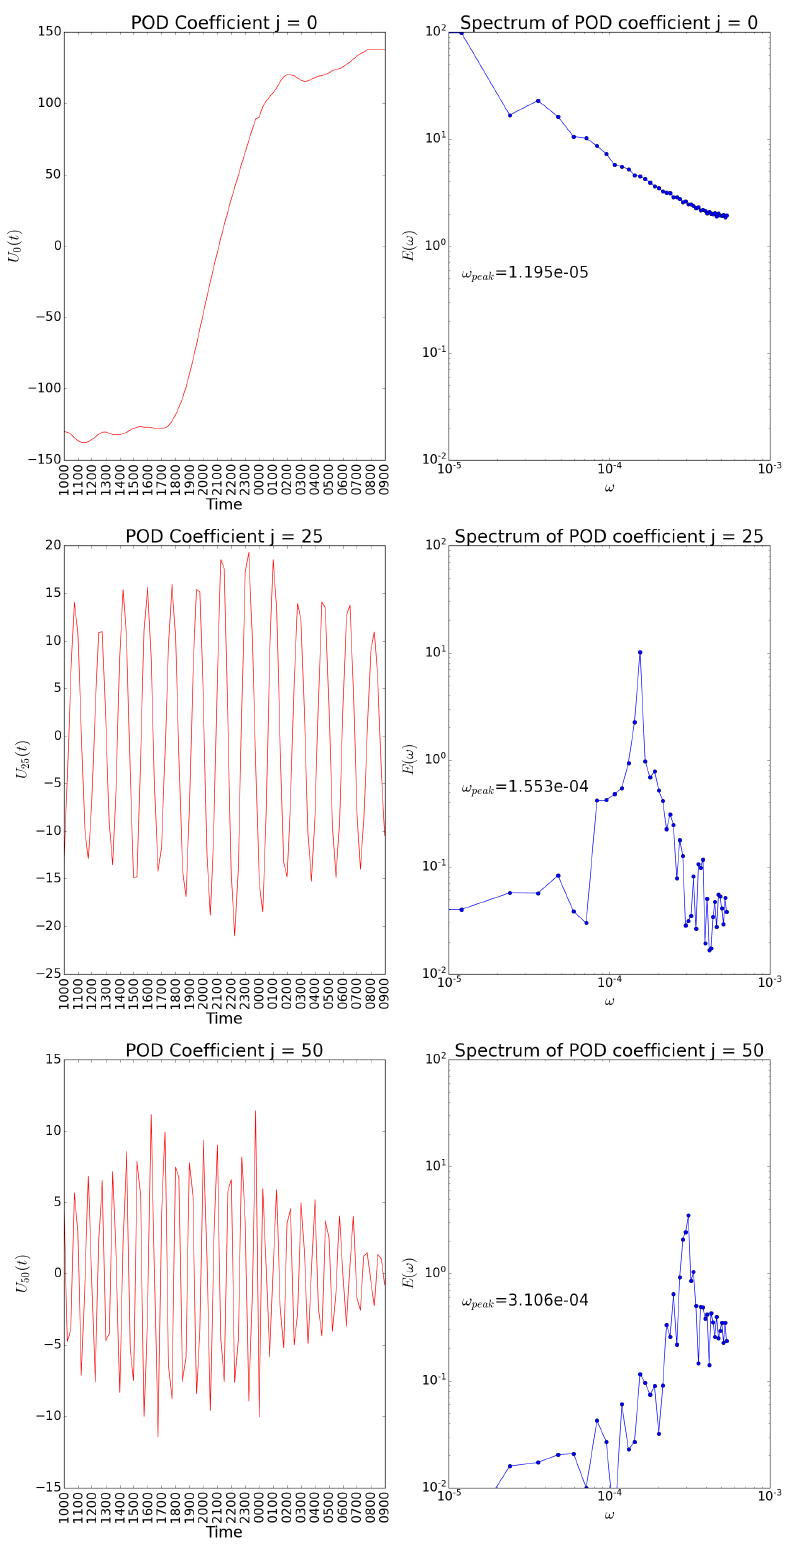
Figure 8. Left, from top to bottom: plot of the temporal evolution of the POD coefficients U 0 ( t ) , U 25 ( t ) and U 50 ( t ) , extracted from the effective temperature field of the Faraji cyclone. Right, from top to bottom: Fourier spectra of the same